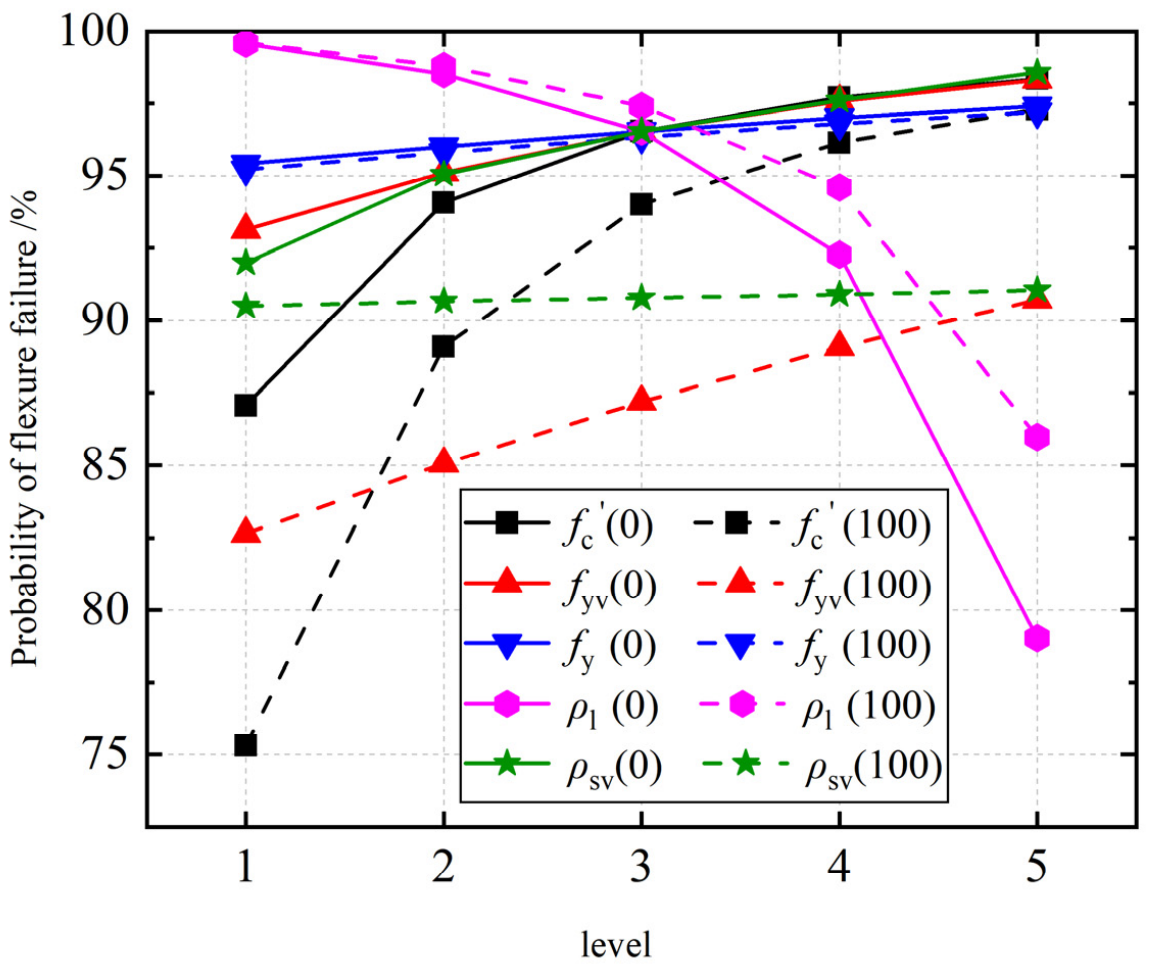
Figure 11. Influence of material parameter variation on failure mode.